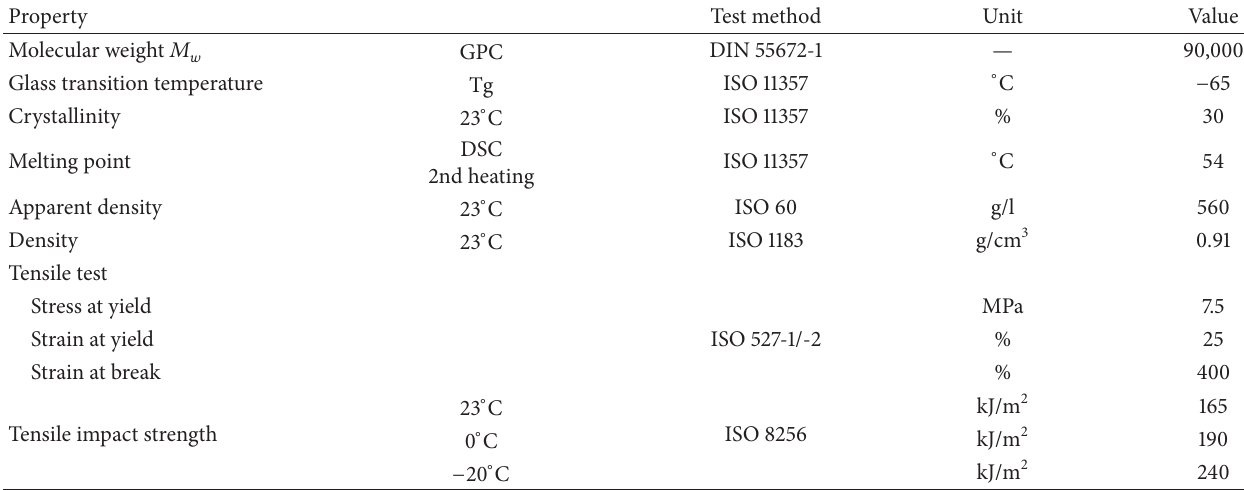
Table 4: Specification of trans-polyoctenamer used in this study.